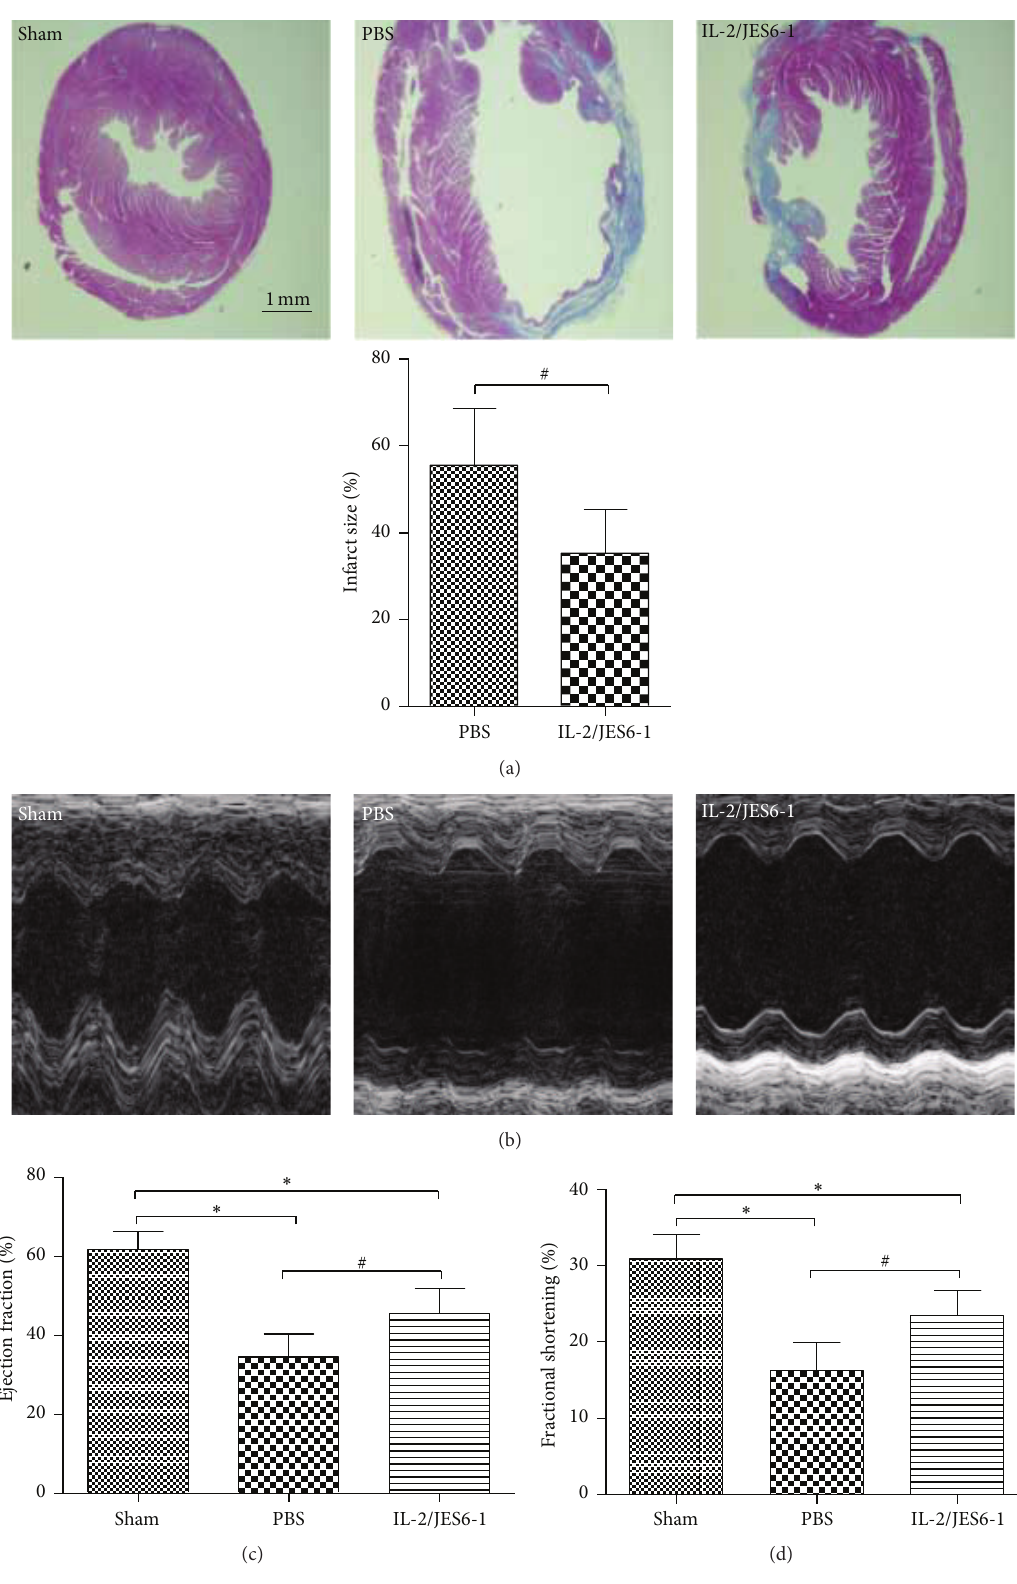
Figure 2: The IL-2/JES6-1 complex attenuates cardiac remodeling on day 14 after MI. (a) Trichrome stained heart sections showed that infarct size was reduced in the IL-2/JES6-1 complex group ( 𝑛 = 6 per group). (b) M-mode echocardiographic images of the left ventricle on day 14 after MI. Left ventricular ejection fraction (c) and fractional shortening (d) on day 14 after MI. ∗ 𝑃 < 0.05 versus the Sham group; # 𝑃 < 0.05 versus the PBS